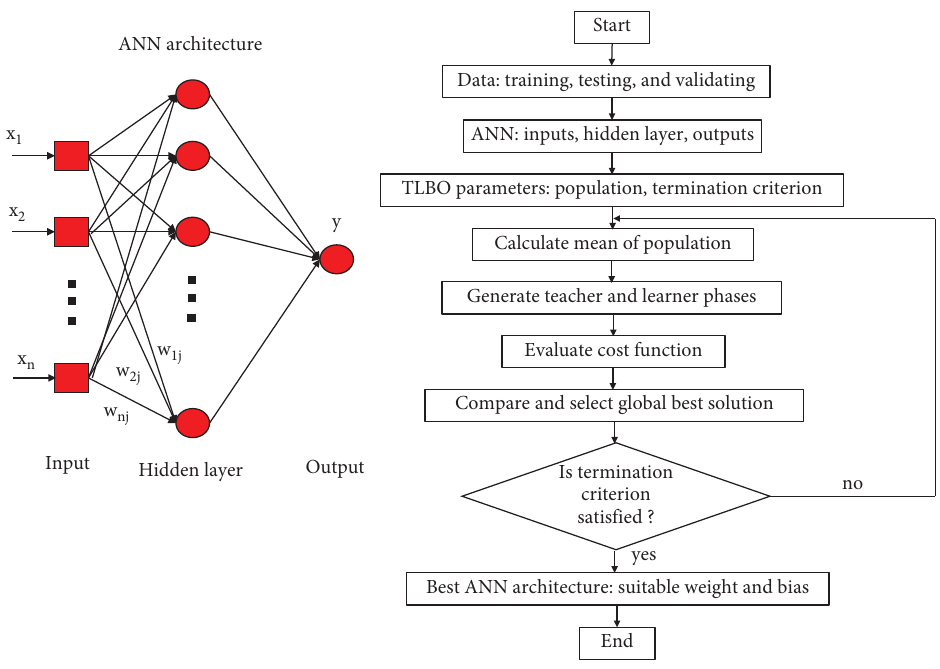
Figure 11: Scheme of optimization of ANN by